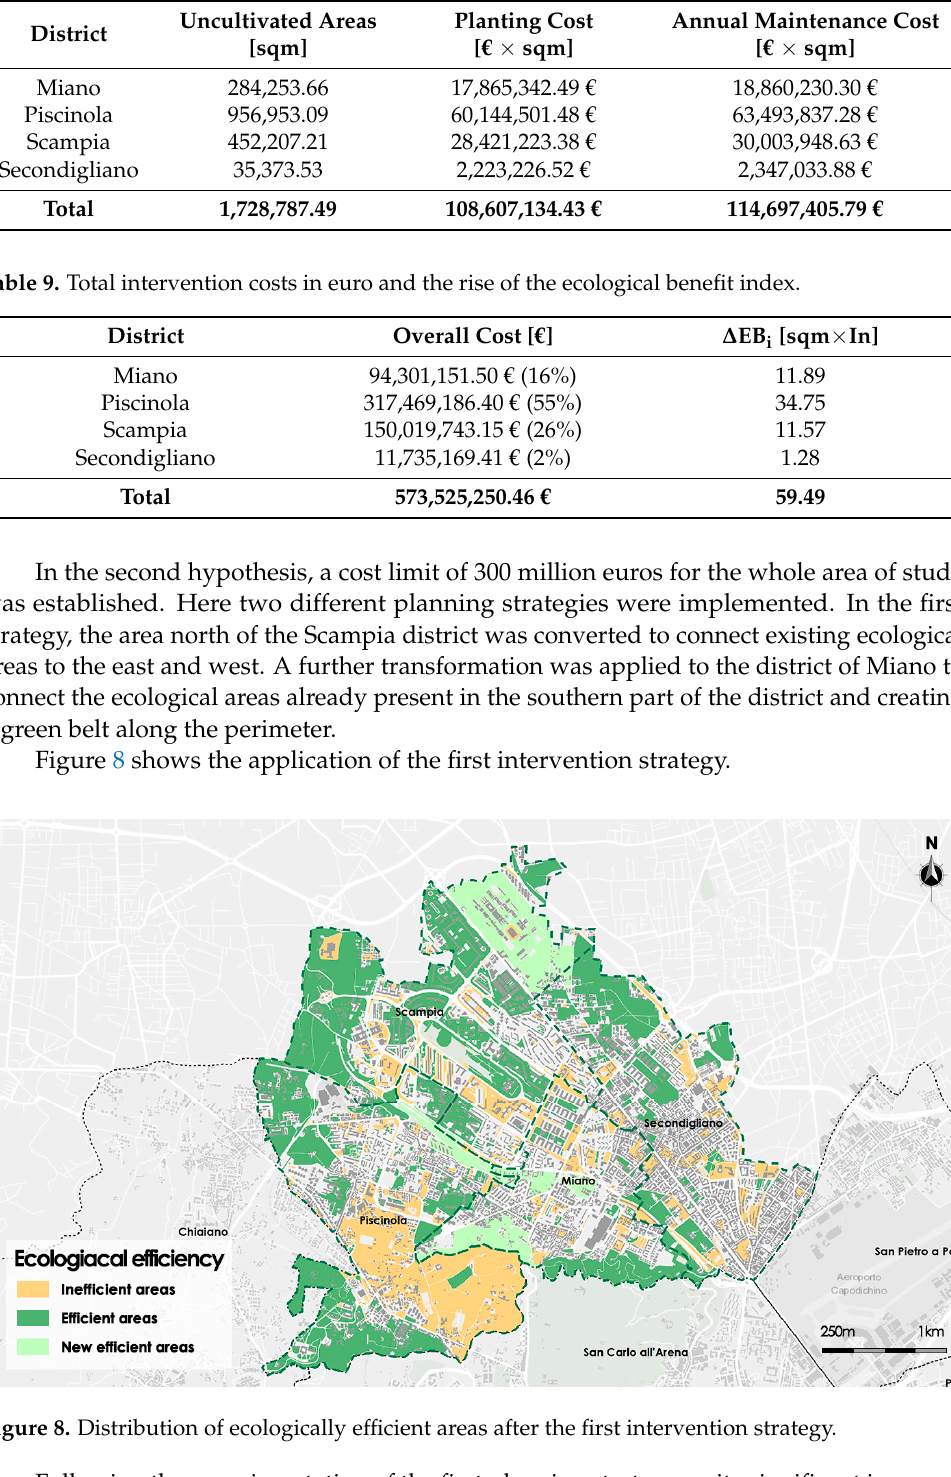
Table 8. Plant and maintenance costs per district in euros per square meter.